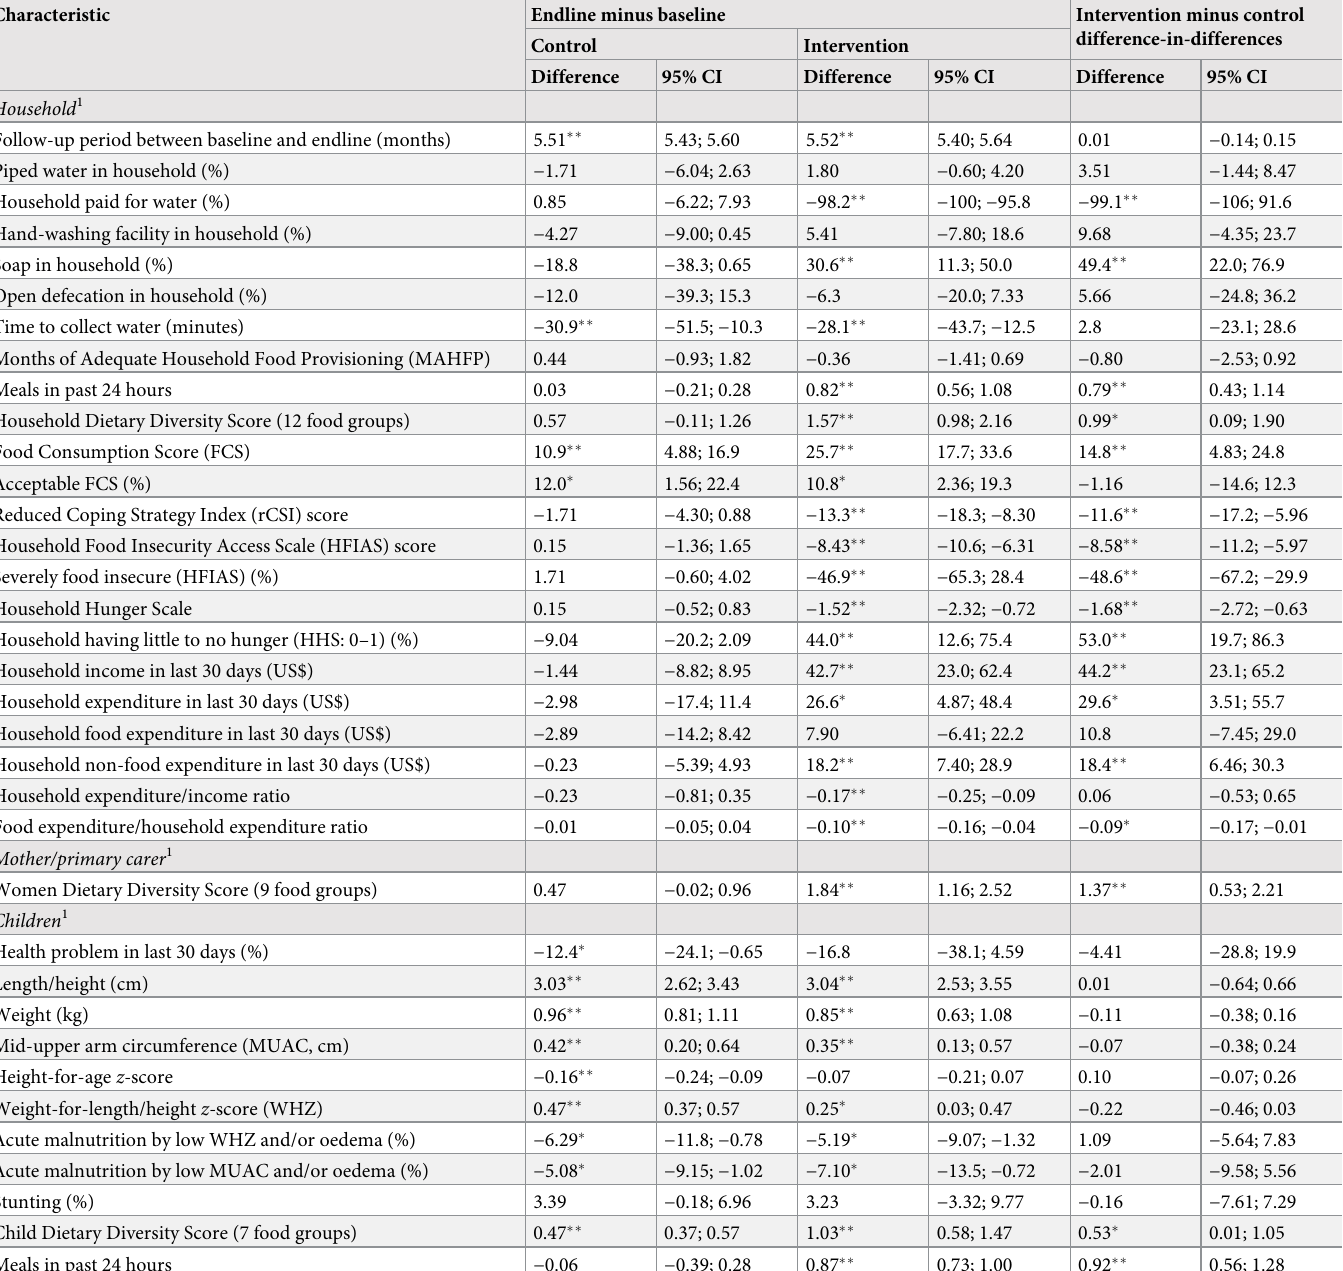
Table 2. Difference between endline and baseline for each study arm and the difference-in-differences.